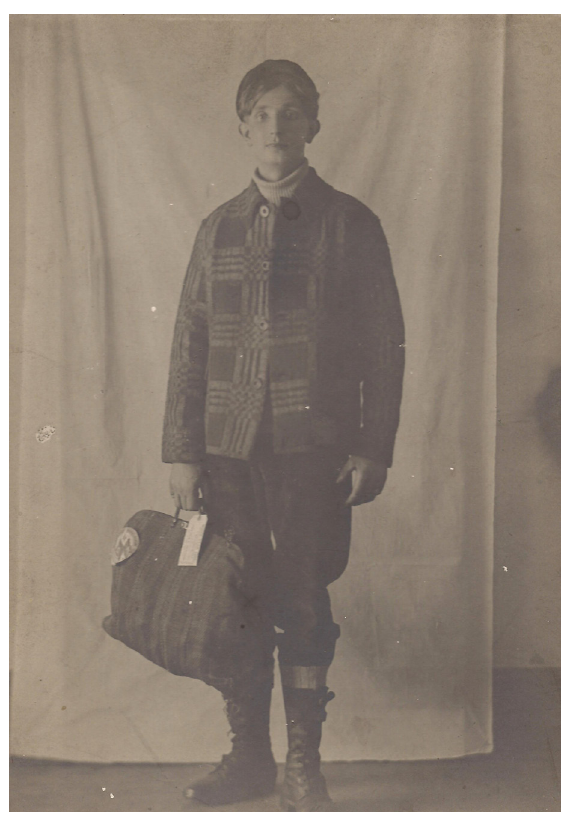
Figure 1: Swedish immigrant and laborer Carl Bruce performing as Sven på Lappen (Sven on the Patch) at Svea Hall, Rockford, Illinois, ca. 1911. (Courtesy of Midway Village Museum,